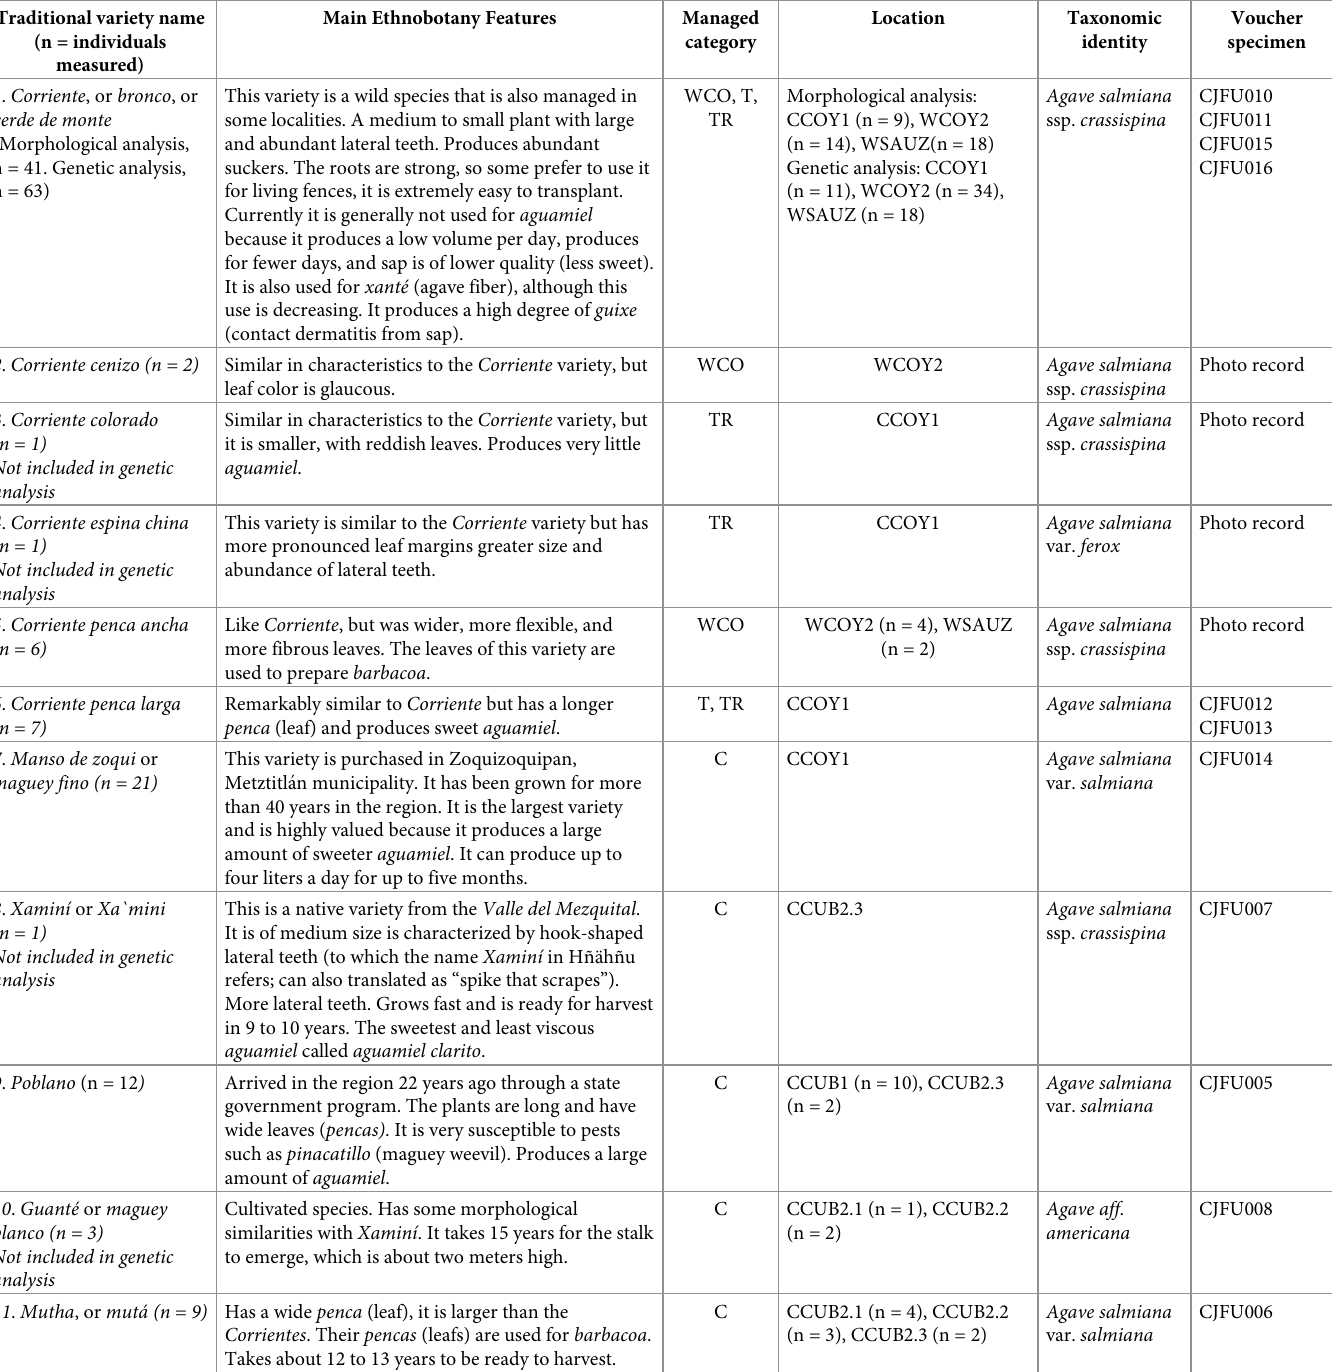
Table 2. Characteristics of traditional varieties of agaves identified by producers in the two study localities in Hidalgo